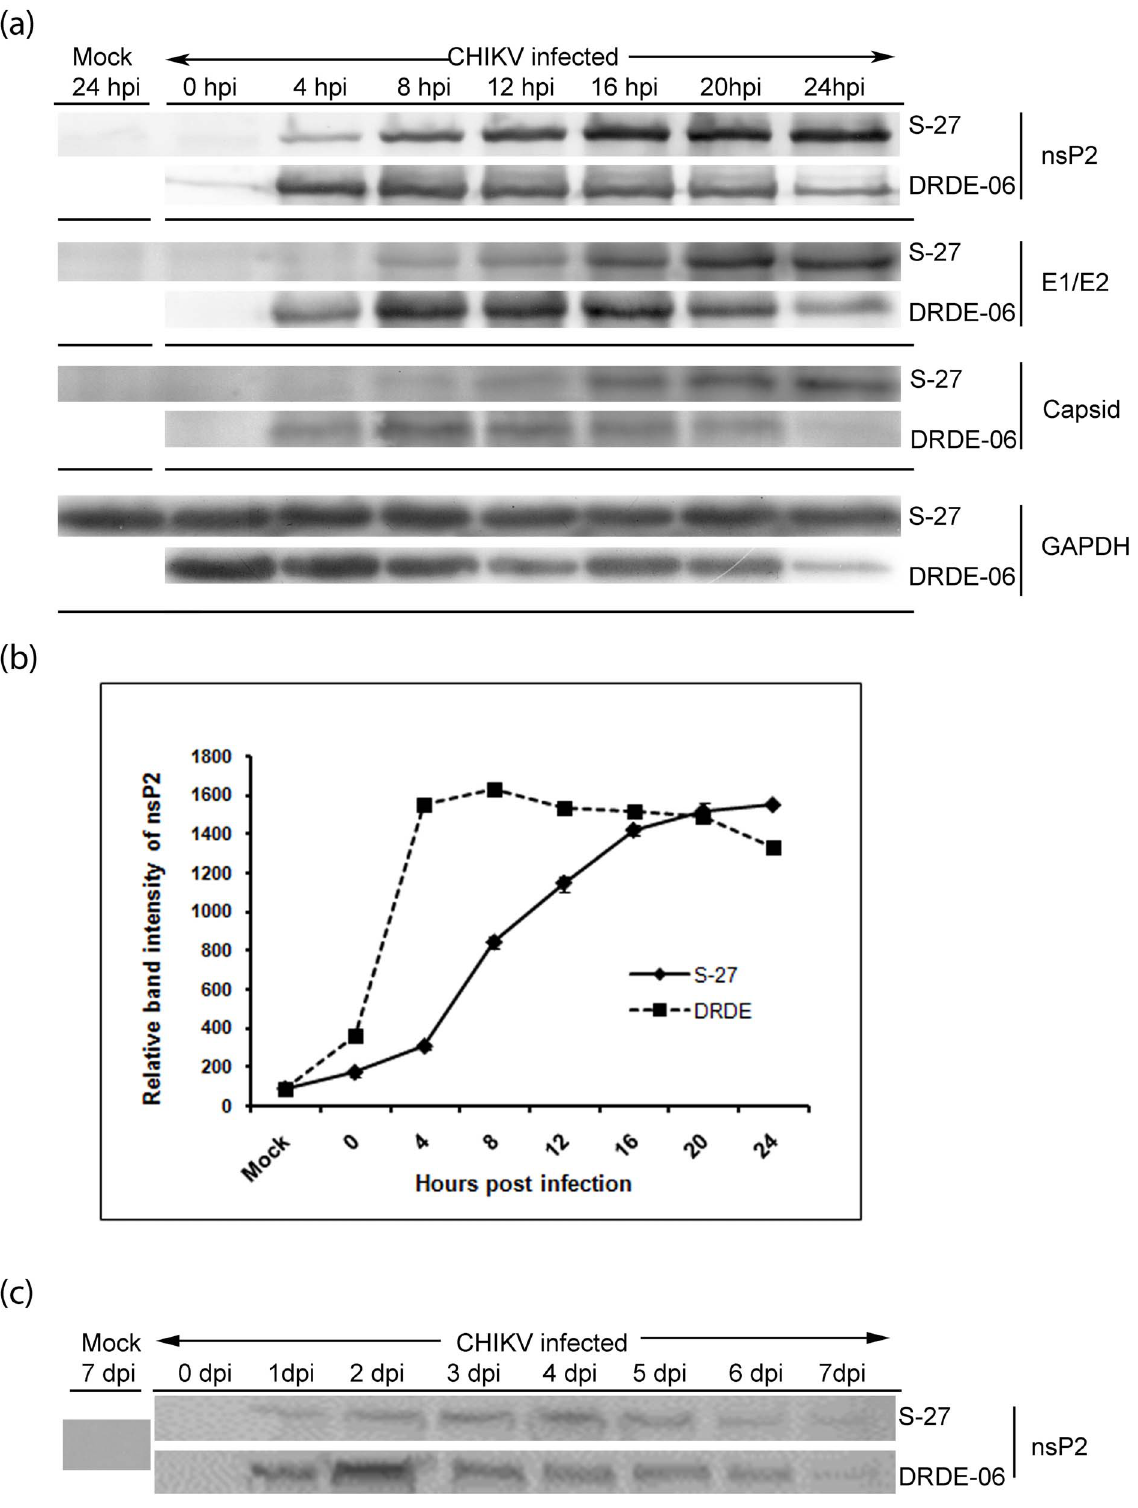
Figure 4. Expression pattern of Chikungunya viral proteins. Vero cells were infected with S-27 and DRDE-06 with MOI 1 and cells were harvested at different times post infection (hpi - hours post infection). (a) Viral proteins (nsP2, E1/E2 and capsid) detected by Western blot by using respective antibodies. GAPDH was used as a loading control. (b) Representation of nsP2 protein expression quantified by Quantity One software. Values were calculated from three independent experiments. (c) C6/36 cells were infected with S-27 and DRDE-06 with MOI 1 and cells were harvested at different days post infection (dpi). Viral protein nsP2 was detected by Western blot using nsP2 polyclonal antibody.